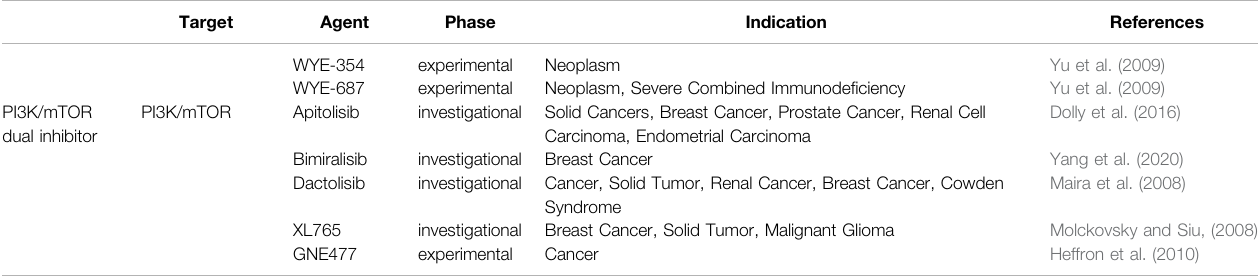
TABLE 3 | ( Continued ) Targets in and inhibitors targeting the PI3K-AKT-mTOR